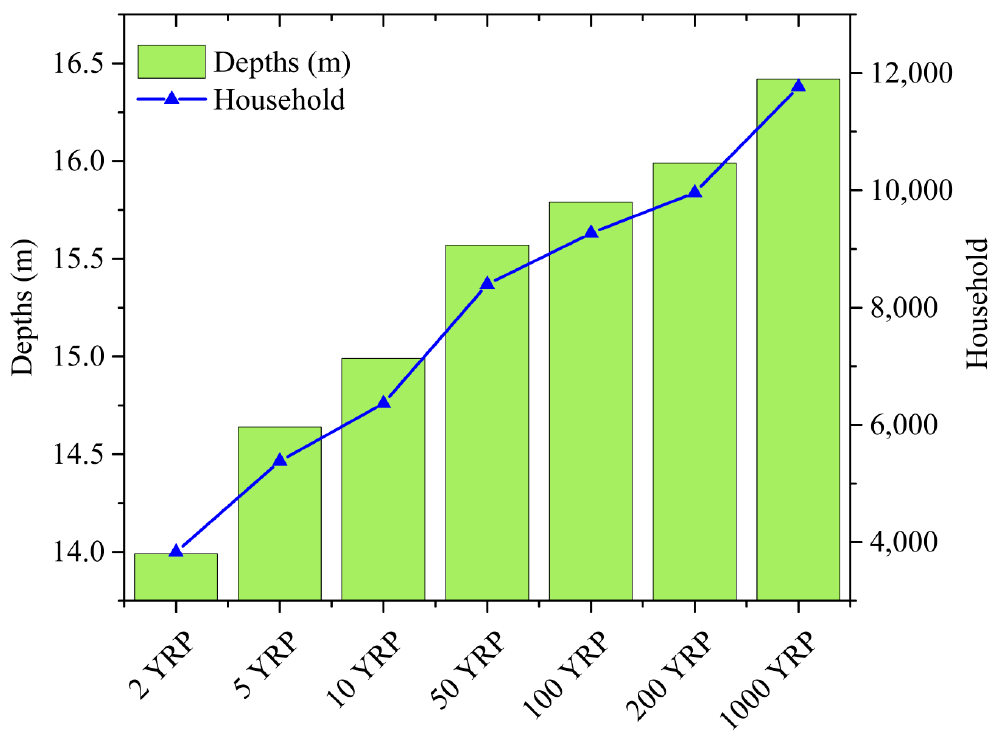
Figure 13. Relationship between the water level depths at Chisapani station (in the river channel) and the number of inundated households downstream (Chisapani station to the Nepal–India border) with different YRP floods.